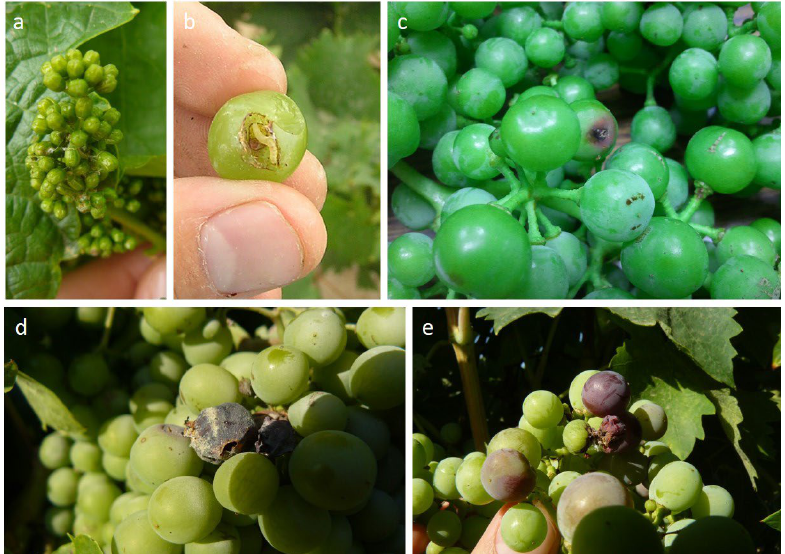
Figure 2. Types of damage caused by Lobesia botrana and associated plant diseases: ( a ) Inflorescence; ( b , c ) berries; ( d , e ) Botrytis cinerea . Photo credit: Julio Prieto-Díaz. ( b , c ) berries; ( d , e ) Botrytis cinerea . Photo credit: Julio Prieto-D í